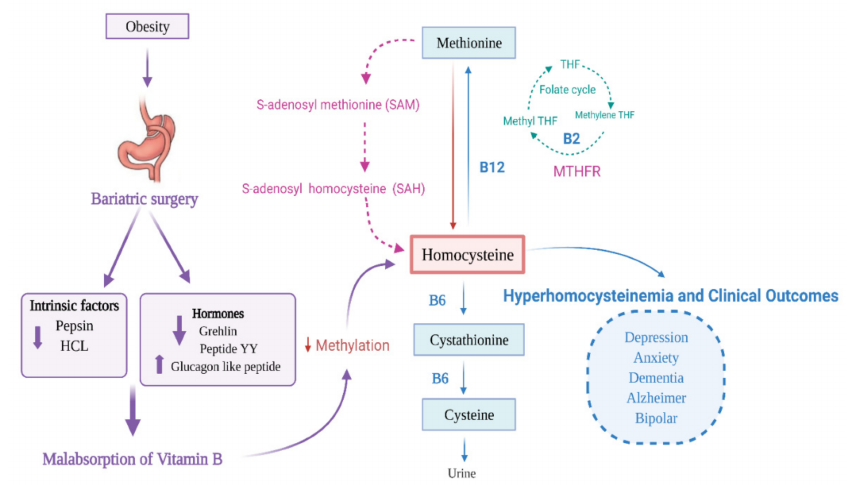
Figure 2. Bariatric surgery, hyper-homocysteinemia, and importance of vitamin